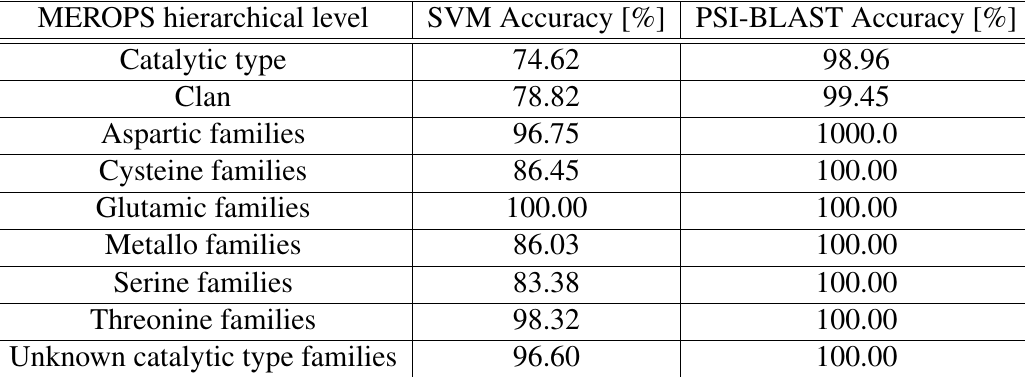
Table 4: Accuracy values for the SVM system and PSI-BLAST.